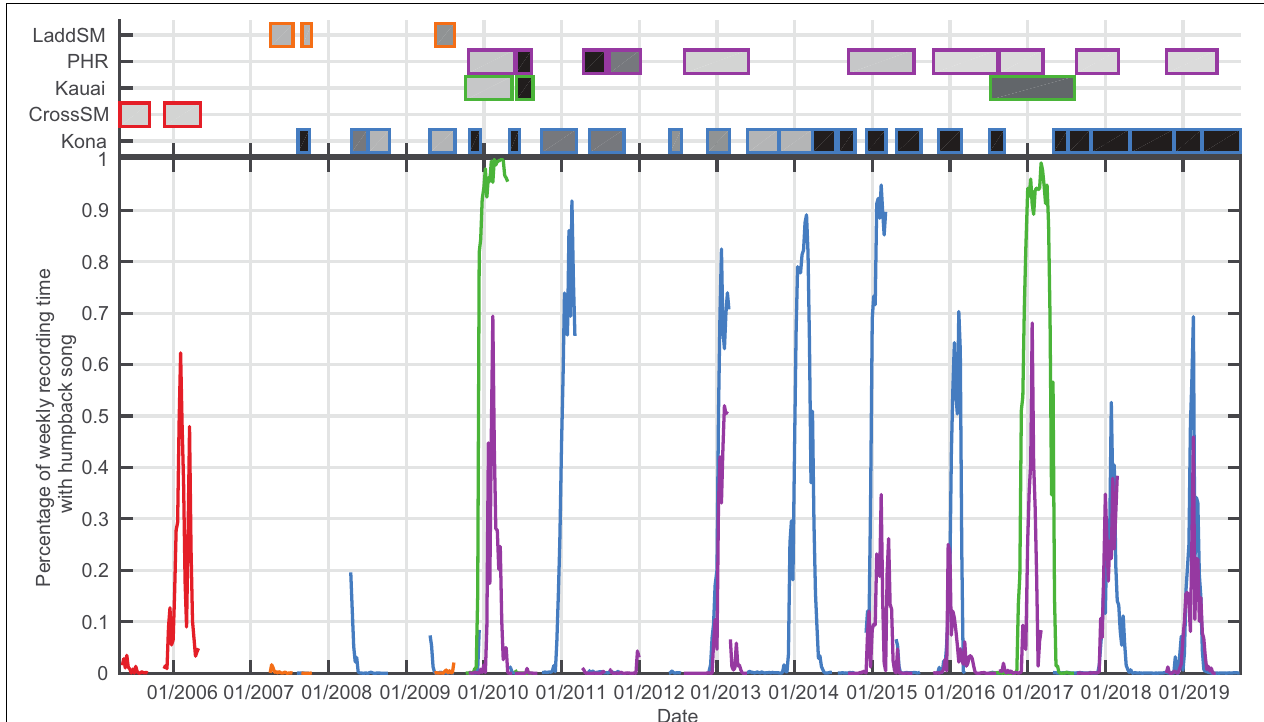
FIGURE 3 | Bottom panel: Percentage of recording time with humpback song per week for the for Hawaiian archipelago sites (Ladd Seamount, Pearl and Hermes Reef (PHR), Kauai, Cross Seamount, Kona). Top panel: Shaded boxes represent the time periods with recordings for each site, with outer color corresponding to the recording site, and shading indicating duty cycle which ranged from 12.5% recording time (light gray) to continuous (black).